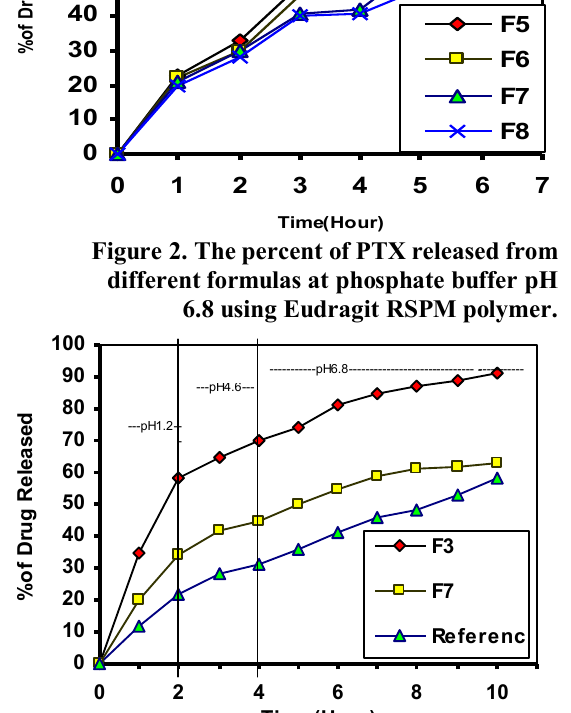
Figure 3. The cumulative percent of PTX released from formulas 3,7 and Reference (Trental 400 mg.) at different pH-medium.